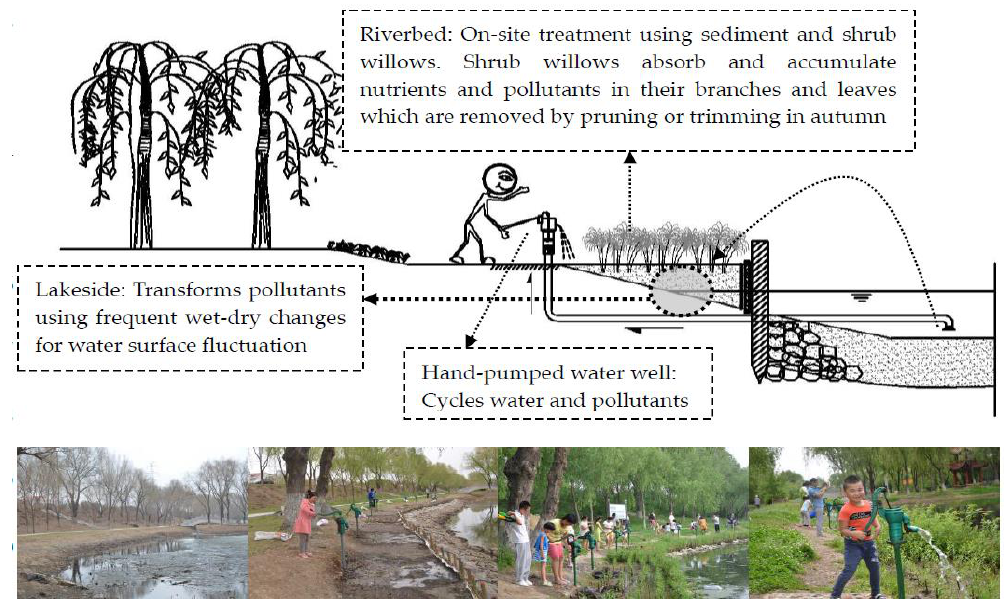
Figure 2. The system design and working principle of the water treatment pond.